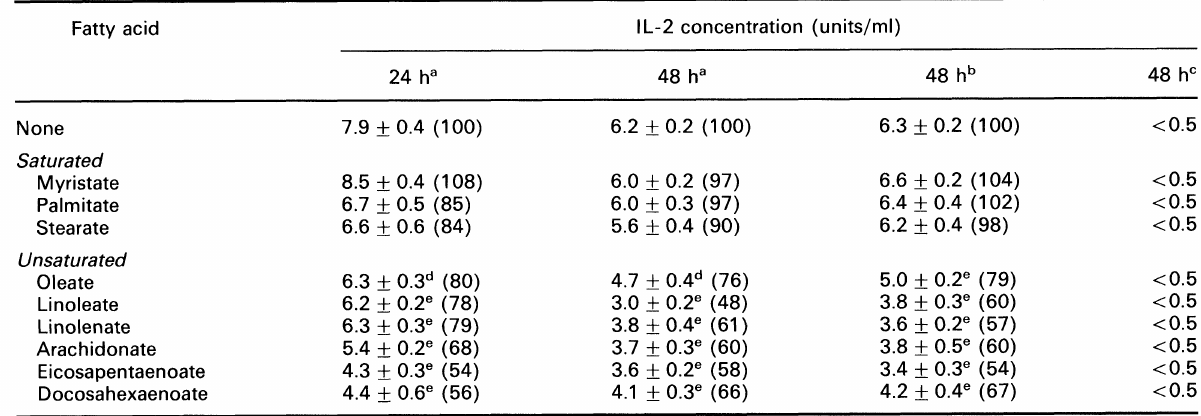
Rat lymph node lymphocytes were .cultured for 24 or 48 h in the presence of Con A and 100/M fatty acid-albumin complexes. The medium was removed, serially diluted two-fold and the concentration of IL-2 determined using the CTLL-2 or G2 b’c cell lines (see Materials and Methods). Assays using the G2 cell line were performed in the absence b or presence of 100 #g/ml IL-2 receptor blocking antibody (NDS 63). Data are the mean 4- SEM of 12 or 6 b’c determinations. Statistical significance vs. control (i.e. no fatty acid addition)" dp< 0.01, ep < 0.001. Numbers in parentheses are IL-2 concentration as a percentage of the control